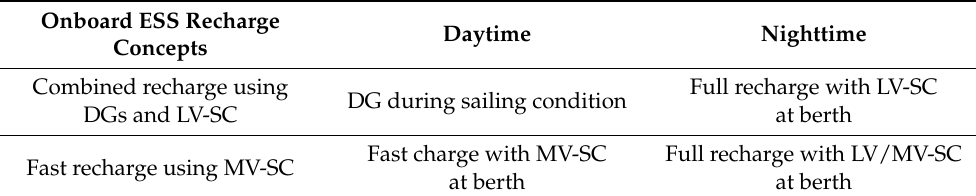
Table 4. Options considered for the recharge of the ship’s onboard